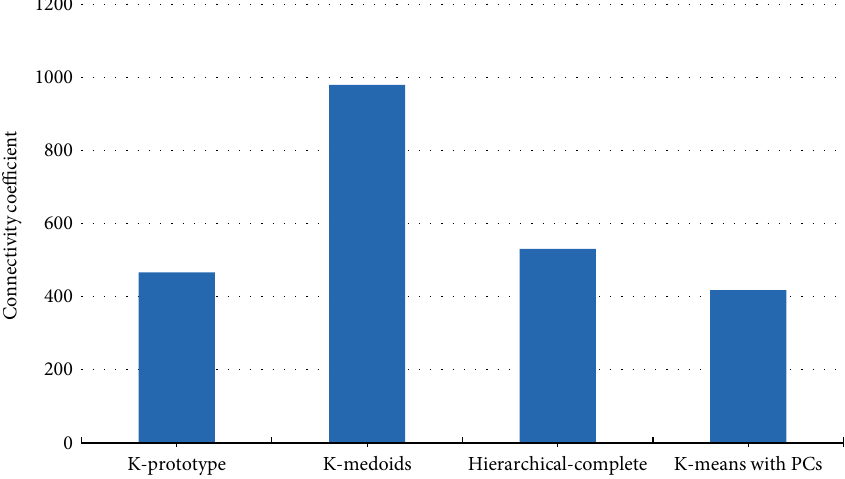
Figure 6: Connectivity coefficient for different clustering methods for the seven clusters.